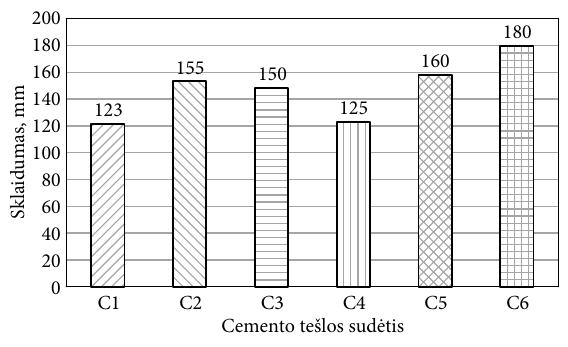
Fig. 4. Changes in the flow of cement slurries